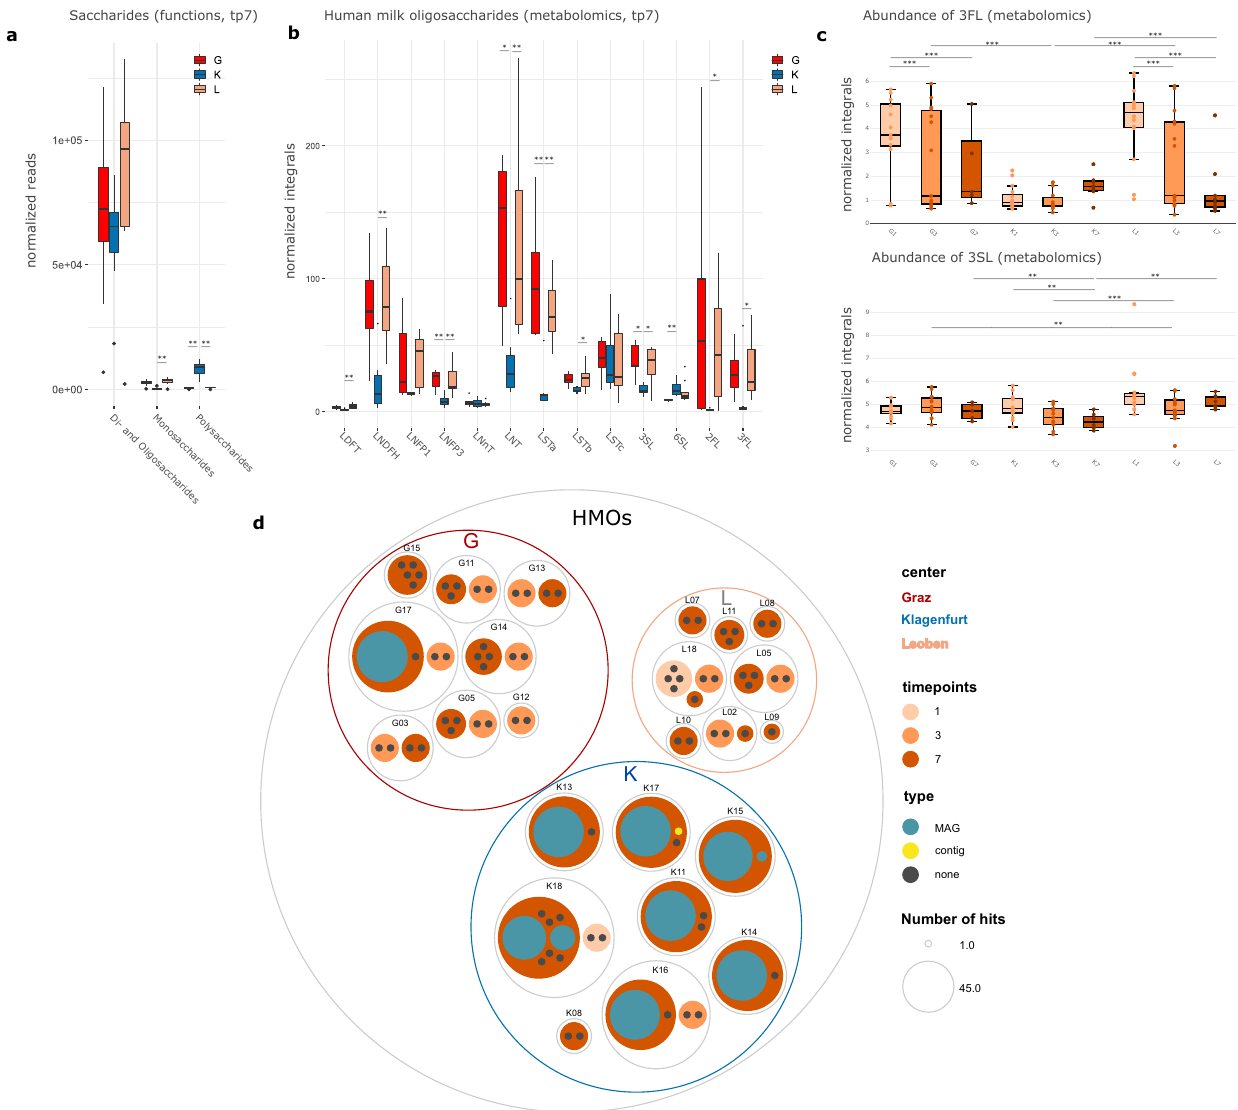
Fig. 4 | Distribution patterns of sugars and HMOs. a Differentially abundant functions (metagenomic dataset) associated with saccharides (di- and oligo- saccharides, monosaccharides and polysaccharides) between the centers, tp7, n =23; Monosaccharides: K:G q <0.001, K:L q <0.001, G:L q =0.949; Di- and Oli- gosaccharides: K:G q =0.057, K:L q <0.001, G:L q =0.949; Polysaccharides: K:G q <0.001, K:L q <0.001, G:L q =0.949; b differentially abundant Human Milk Oli- gosaccharides (HMOs) between centers (metabolomic dataset, tp7, n =23 biolo- gically independent samples) LDFT: K:G q =0.091, K:L q =0.003, G:L q =1; LNDFH: c differentialabundanceoftheHMOs3 ′ -fucosyllactose(3 ′ FL)and3 ′ -sialyllactose(3 ′